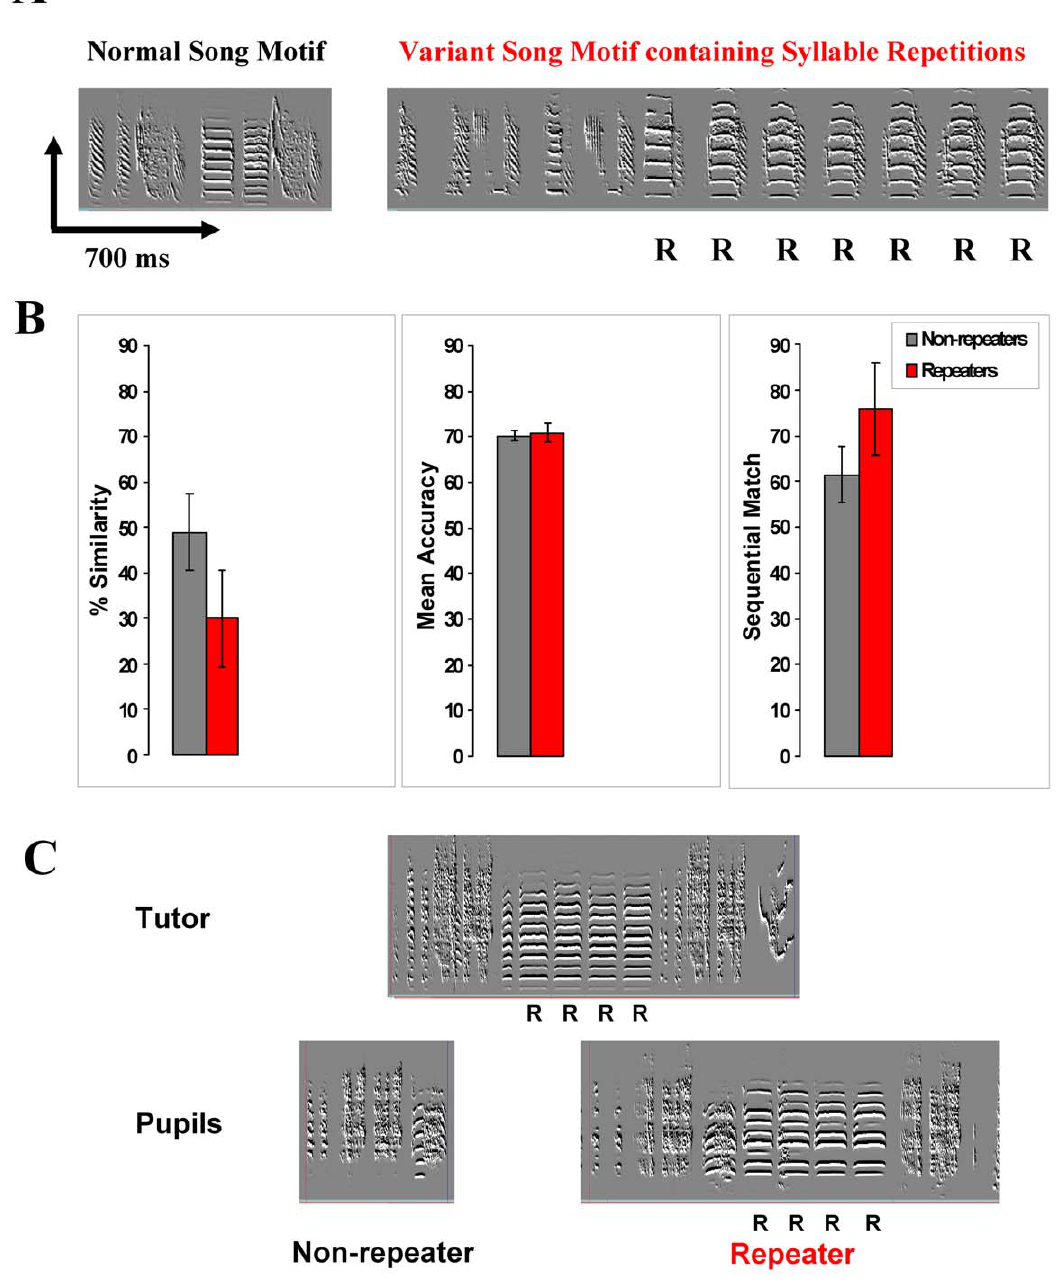
Figure 1. Song learning in syllable repeaters and non-repeaters. A. Spectrograms of non-repeater (left) and repeater (right) song motifs. The R’s indicate repeated syllables. B. Learning of tutor’s songs by tutored repeaters and non-repeaters. Bar graphs show no significant difference in % similarity, mean accuracy and sequential match of pupil song motifs with the respective tutor motifs, between repeaters (n=8) and non-repeaters (n=8) tutored by repeater tutors in this study. The error bars represent standard errors of the mean (SEMs) C. Spectrograms of the songs of a tutor and its two pupils as adults, one of which is a repeater and the other a non-repeater. Repeated syllables in the tutor’s as well as repeater pupil’s song are indicated by the letter